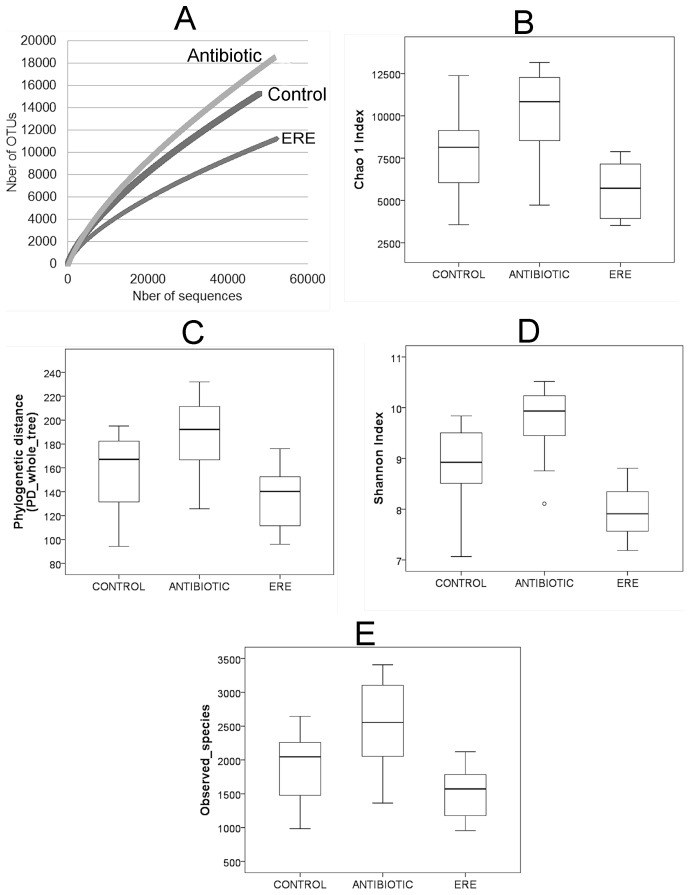
Rarefaction curves represent an approximation to the number of species identified for the total number of sequences obtained (A). The number of species was represented by the number of operational taxonomic units (OTUs). Curves were calculated with RarefactWin software at 97% similarity level corresponding to species-level phylotypes. Rarefaction analysis also included the estimation of the diversity of bacterial taxa in each sample with different metrics within the QIIME pipeline, such as the alpha diversity indices: Chao1 (B), Shannon (D), Phylogenetic distances (C) and Observed Species (E).